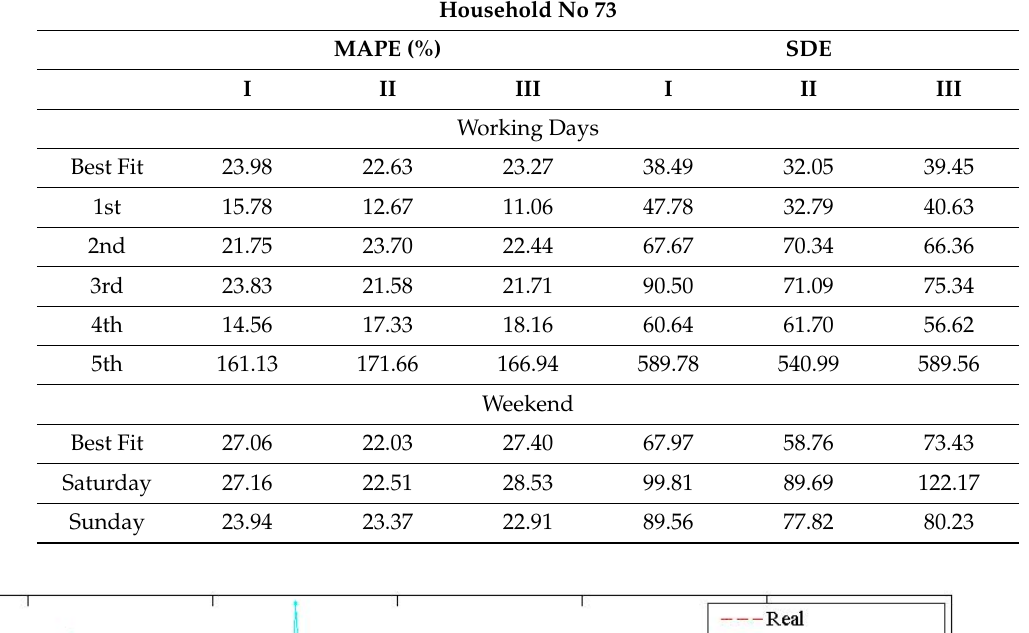
Table 5. Forecasting error values of the outputs.